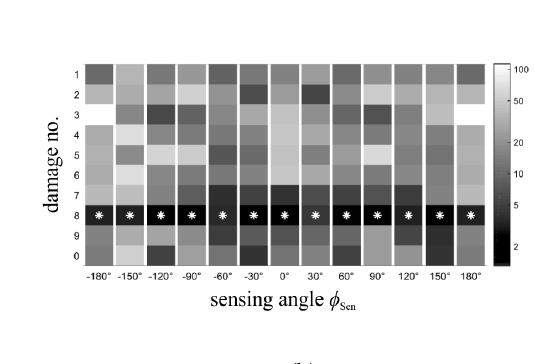
(cid:12) (cid:12) (cid:12) u A0 IN (cid:12) . ( b ) Deviation metric M ( C AA ) of